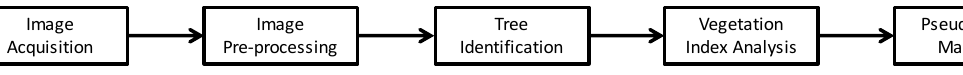
Figure 7. Image acquisition and processing flowchart. Table 2. Vegetation indices for image analysis.